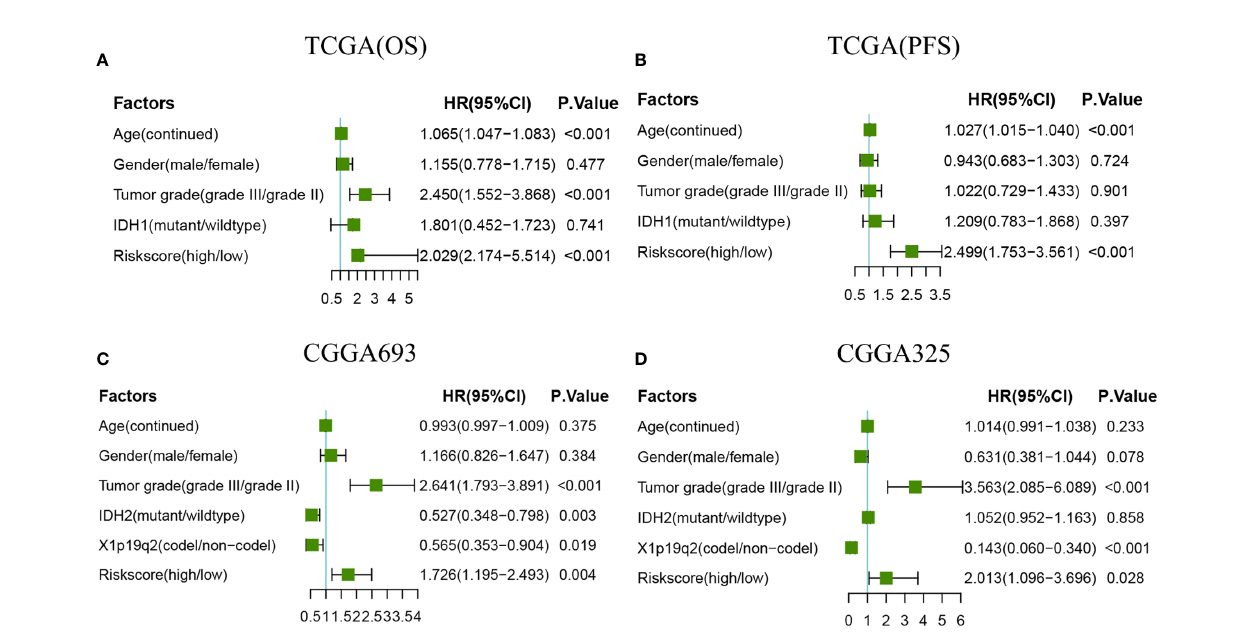
FIGURE 5 | Forest plots of multivariate Cox regression. (A) Forest plots of multivariate Cox regression in TCGA(OS). (B) Forest plots of multivariate Cox regression in TCGA(PFS). (C) Forest plots of multivariate Cox regression in CGGA693. (D) Forest plots of multivariate Cox regression in